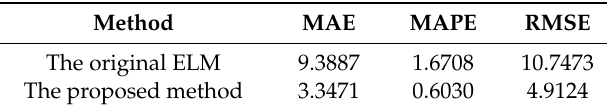
Table 5. Metrics of comparison experiments (Group 1).